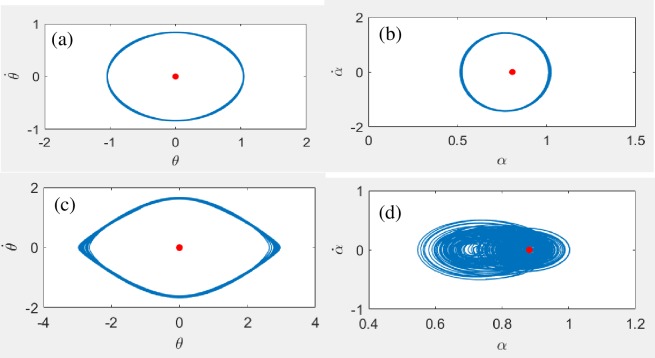
The dynamic simulations of the bird-like flapping wing robot under an ideal environment.